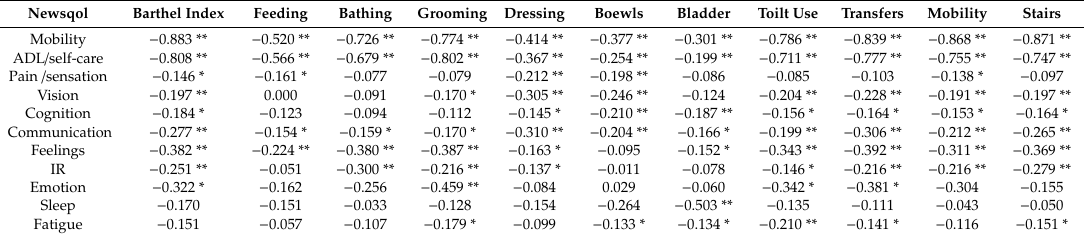
Table 5. Values of Convergent construct analysis (Spearman’s coe ffi cient) of the NEWSQOL and Barthel